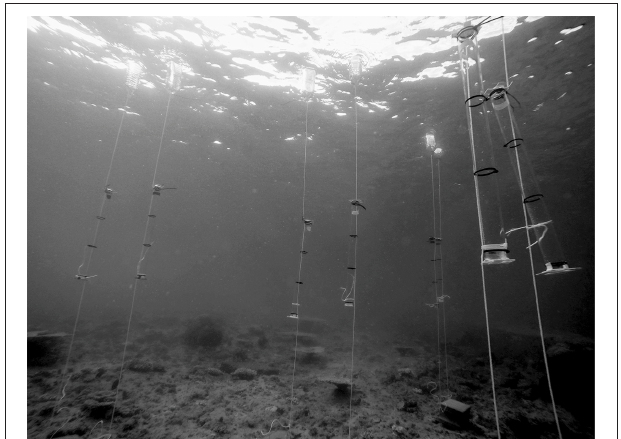
FIGURE 1 | Photograph of 68-cm long tubes deployed in situ at ∼ 3.3-m MD on the shallow fringing reef near Sesoko Station in August 2016. Ambient and high pCO 2 treatments were haphazardly distributed among 8